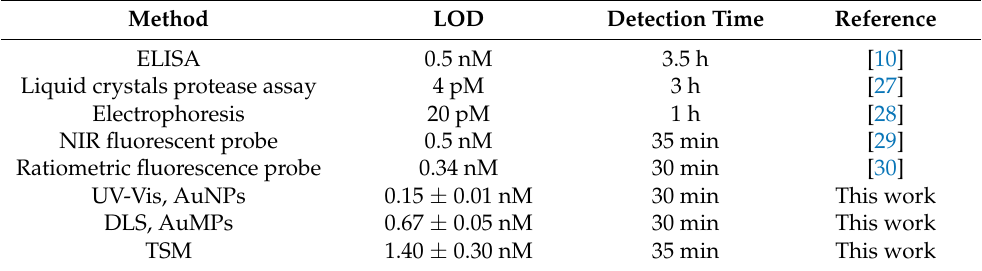
Table 1. The comparison of LOD and detection time of chymotrypsin